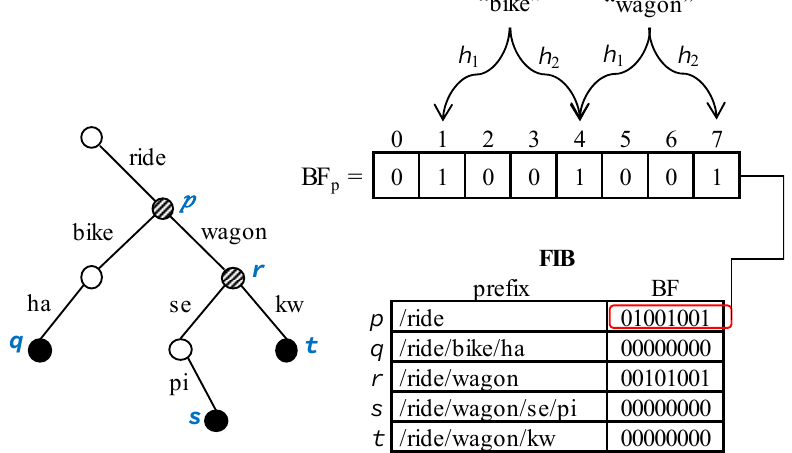
Figure 4. The Bloom filters of prefixes to represent the existence of their descendants.